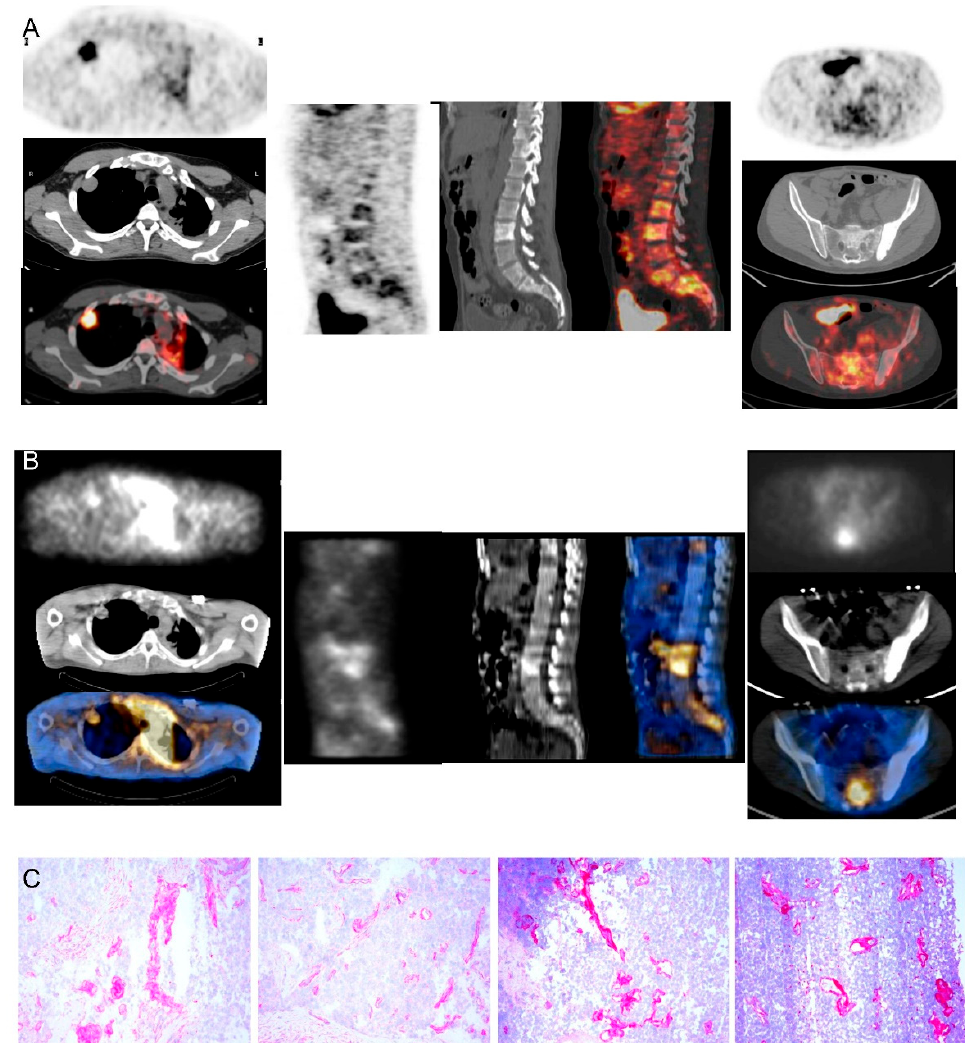
Figure 3. Comparison between [ 18 F]FDG-PET/CT, Radretumab SPECT/CT, and immunohistochem- ical analysis in a thymoma B3 patient (#5). Pre-treatment PET/CT ( A ) shows high [ 18 F]FDG uptake in a nodule in the right lung (left panels) and diffuse uptake in the spine (middle and right panels). SPECT/CT ( B ) outperforms PET/CT findings, showing highly specific Radretumab uptake in right lung (left panels) and spine (middle and right panels). Immunohistochemical analysis ( C ) shows intense ED-B expression in tissue samples, confirming SPECT/CT findings.